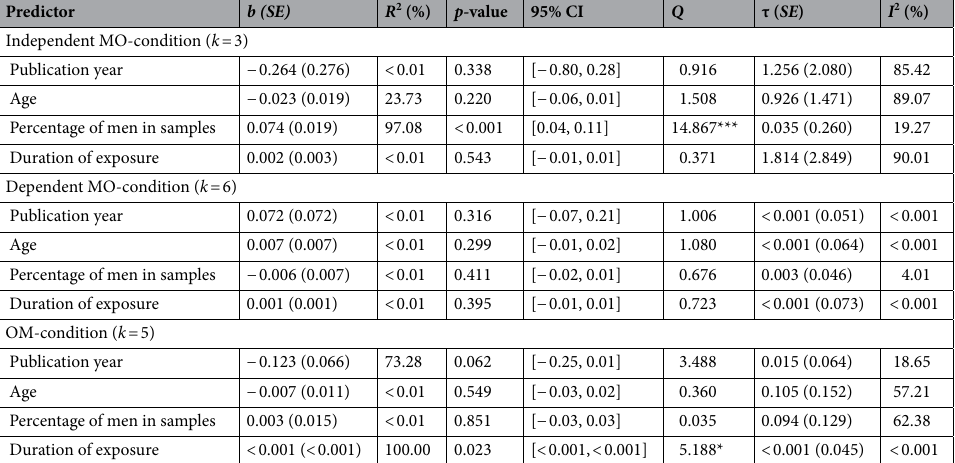
Table 5. Numerical outcomes of linear precision-weighted meta-regressions for three independent meta- analyses. Independent MO = independent-groups pretest–posttest designs examining KV448 versus silence 11,27,28 ; Dependent MO = one-group pretest–posttest designs examining KV448 versus silence 7,12,25,26 , OM = one-group pretest–posttest designs examining other music versus silence 12,25,26,29 ; positive signs indicate a beneficial effect of KV448 (MO) or other music (OM) compared to silence; k = number of effect sizes included in the respective condition; b = unstandardized regression coefficient; R 2 = proportion of variance in the dependent variable explained by the independent variable; SE = standard error; 95% CI = 95% lower and upper bound of 95% confidence interval; Q = Cochran’s Q test statistic for heterogeneity; τ 2 =